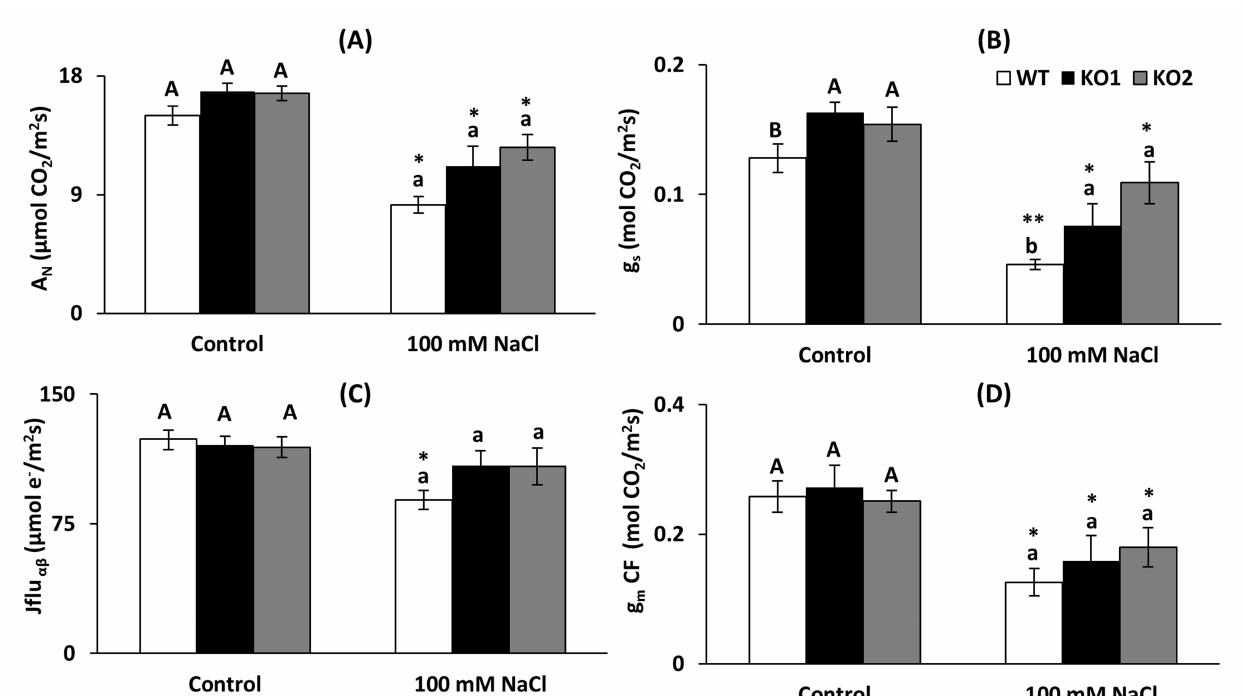
Figure 9. Photosynthetic parameters in leaves of A. thaliana wild type (WT) and two KO Attrxo1 mutant lines grown in the absence (Control) and presence of 100 mM of NaCl. ( A ) Net photosynthetic assimilation (A N ), ( B ) stomatal conductance to CO 2 (g s ), ( C ) electron transport rate (J flu ) and ( D ) mesophyll conductance from curve-fitting (g mCF ). Data are the mean ± SE of at least 9 replicates. Different letters indicate significant differences ( p < 0.05) among genotypes in each condition according to the Tukey’s test, and the asterisks indicate significant differences of each genotype in salinity compared to the control condition using the t -Student’s test ( p <